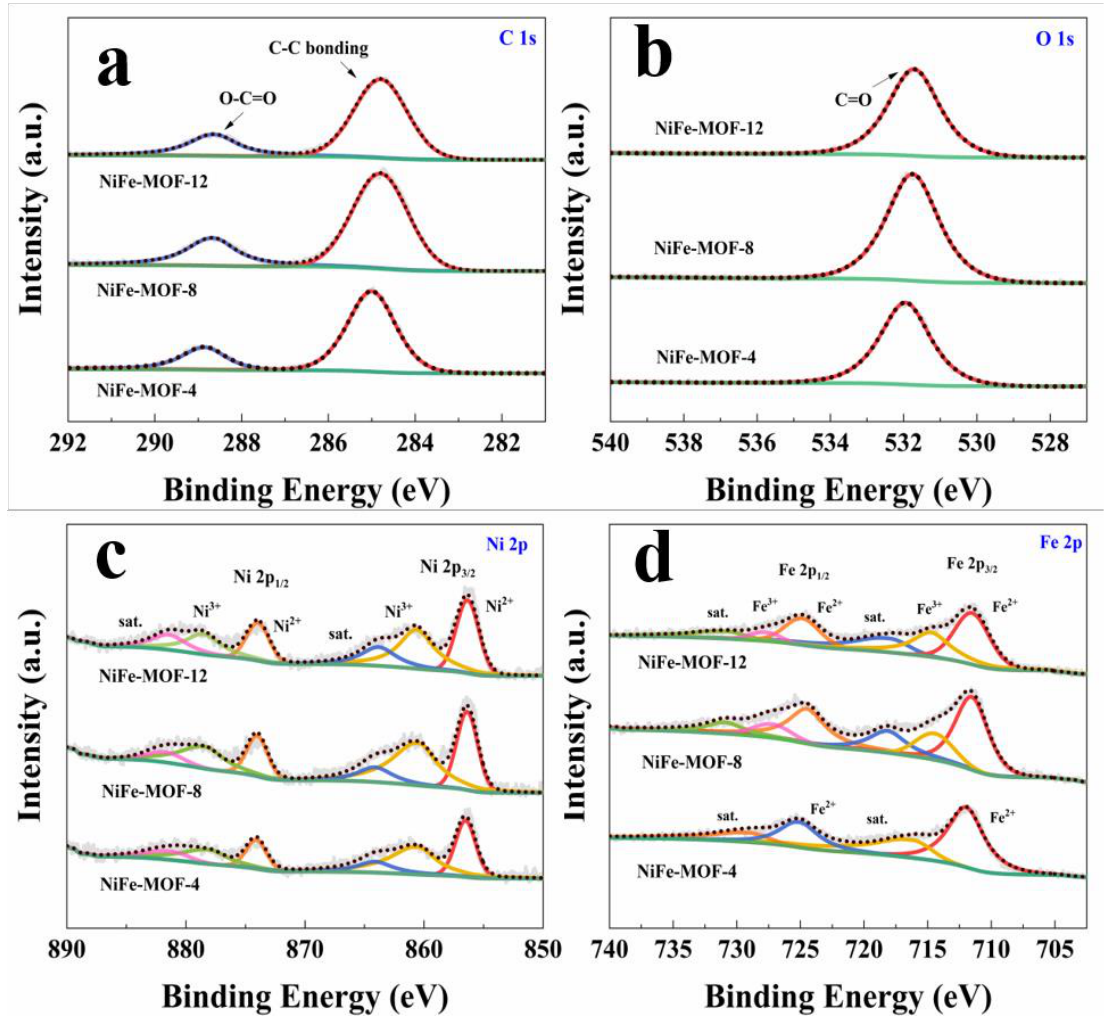
Figure 4. XPS spectra of NiFe-MOF-X: High-resolution XPS spectra of ( a ) C 1s; ( b ) O 1s; ( c ) Ni 2p; and ( d ) Fe 2p.